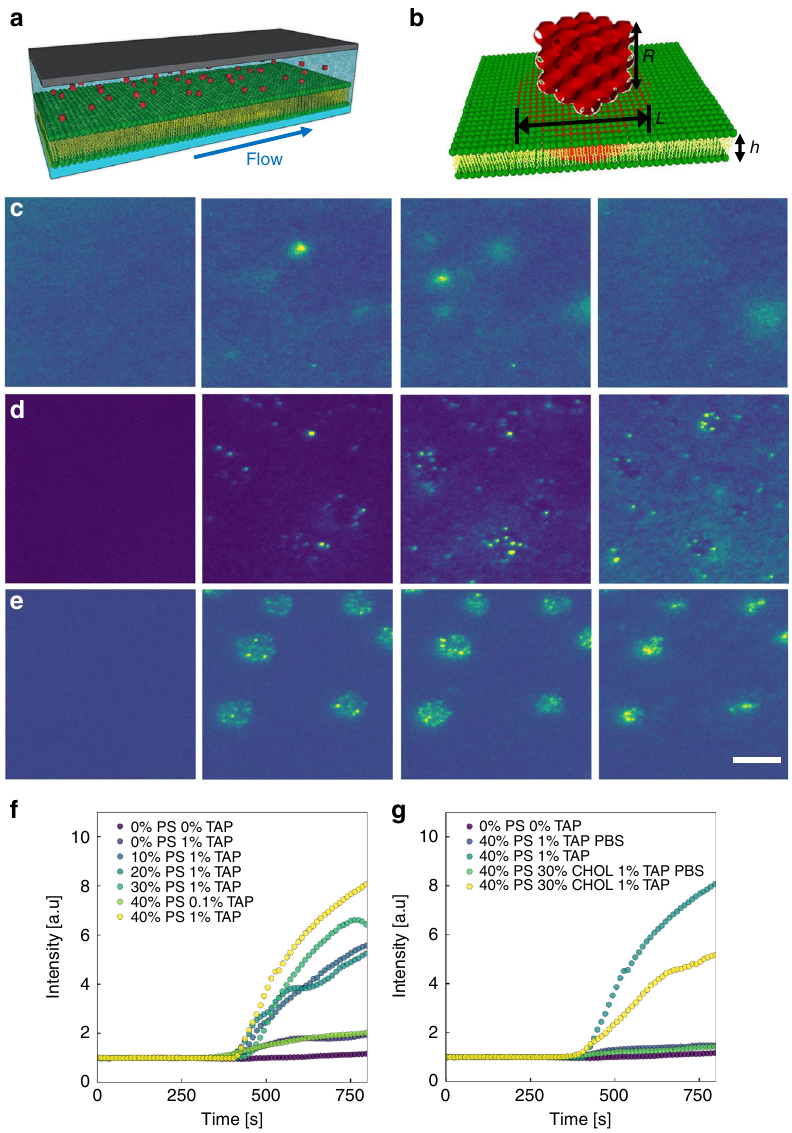
Fig. 2 Cubosome fusion into lipid bilayer under fl ow. a Illustration of cubosomes in fl ow above SLB. b Illustration of single cubosome above SLB. The interacting system is described by the cubosome length R , increasing fl uorescent footprint L and bilayer height h . c TIRF snapshots highlight successive fusion events of MO cubosomes with DOPC bilayer. d TIRF snapshots highlight successive fusion events of 1% DOTAP cubosomes with 40% DOPS bilayer. e TIRF snapshots highlight successive fusion events of 1% DOTAP cubosomes with 40% DOPS bilayer in PBS. Scale bar = 5 µ m. f The total fl uorescence signal recorded for cubosome introductions with various lipid compositions. g The total fl uorescence signal recorded for